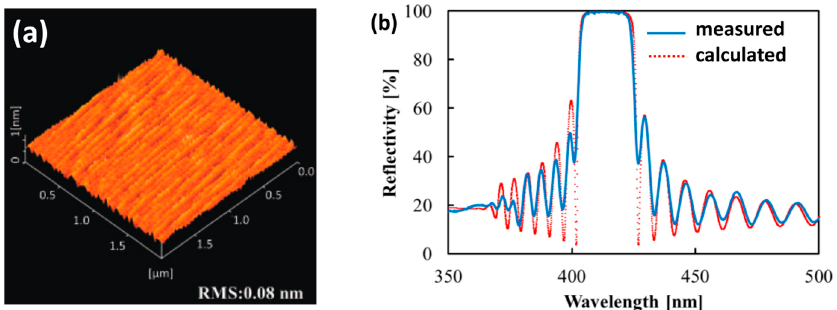
Figure 7. ( a ) 2 × 2 µ m 2 atomic force microscope (AFM) image of a 45-pair n-type conducting AlInN / GaN DBR. ( b ) Measured and simulated reflectance spectra of the AlInN / GaN DBR. Reprinted from Ref [79,81], Copyright 2016 Applied Physics Express and 2018 Reports on Progress in Physics.